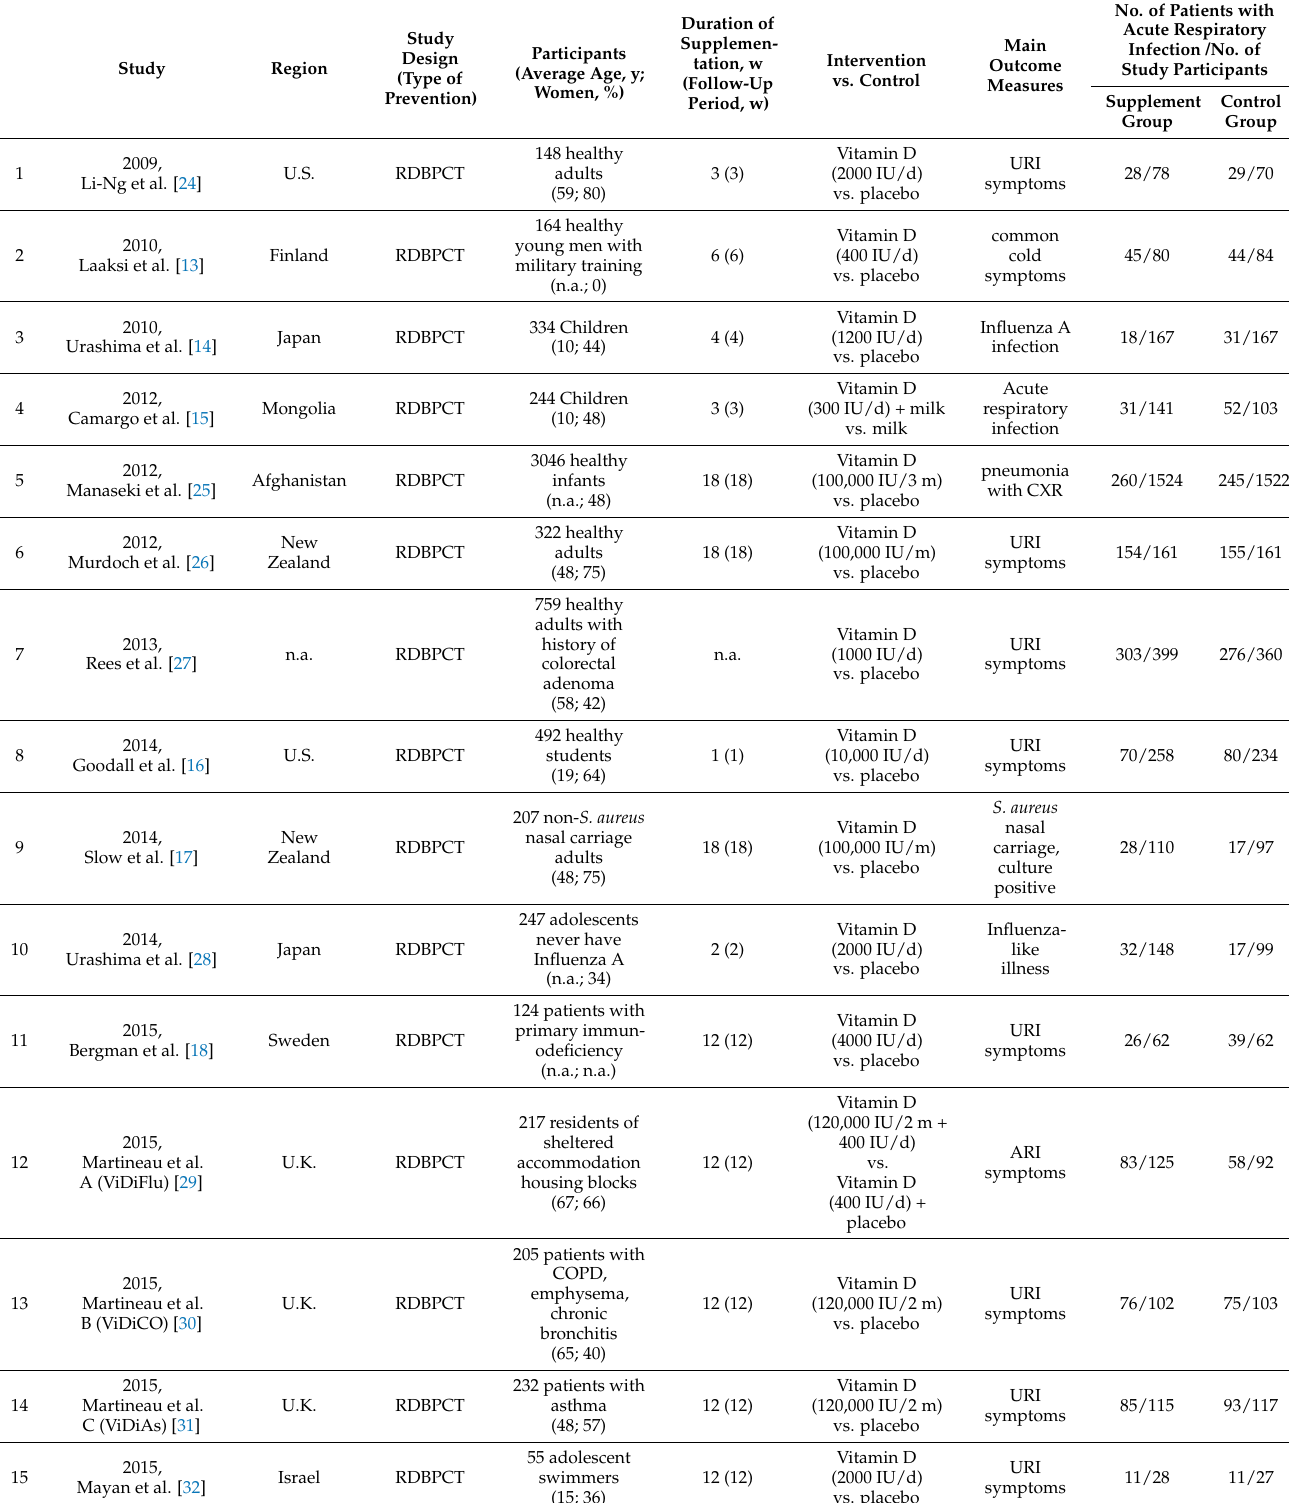
Table 1. Characteristics of trials included in the final meta-analysis ( n =